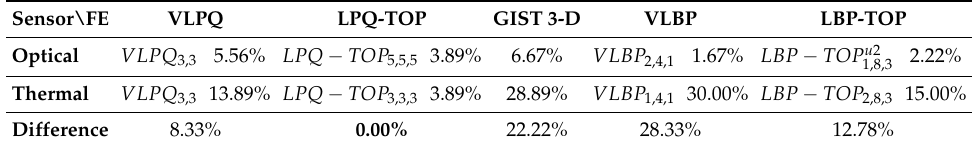
Table 7. BPCER20 comparison between the optical and thermal sensors.